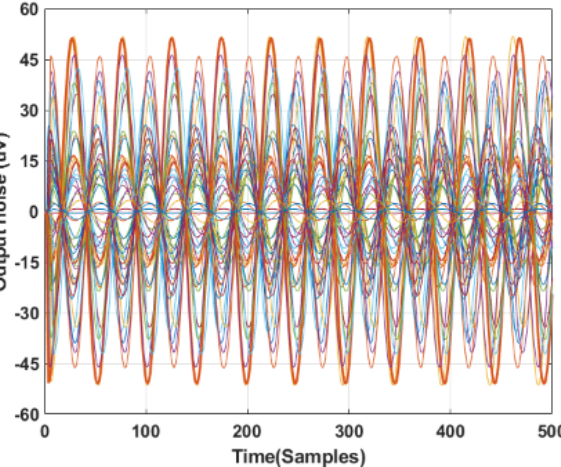
Figure 7. Noise analysis of the proposed pre-amp stage with Zep = 0.